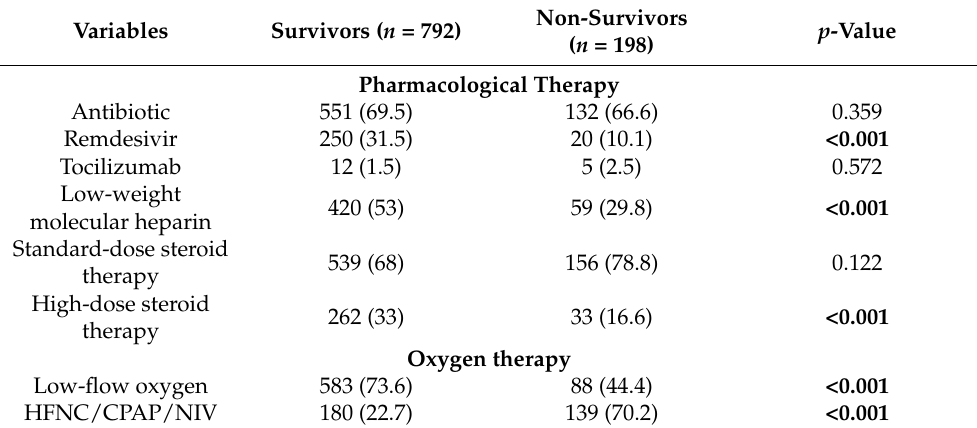
HFNC—high-flow nasal cannula; NIV—non-invasive ventilation; CPAP—continuous positive airway pressure. Cox regression analysis (reported in Table 6) showed that risk factors independently associated with 30-day mortality were chronic obstructive pulmonary disease (HR 1.98,